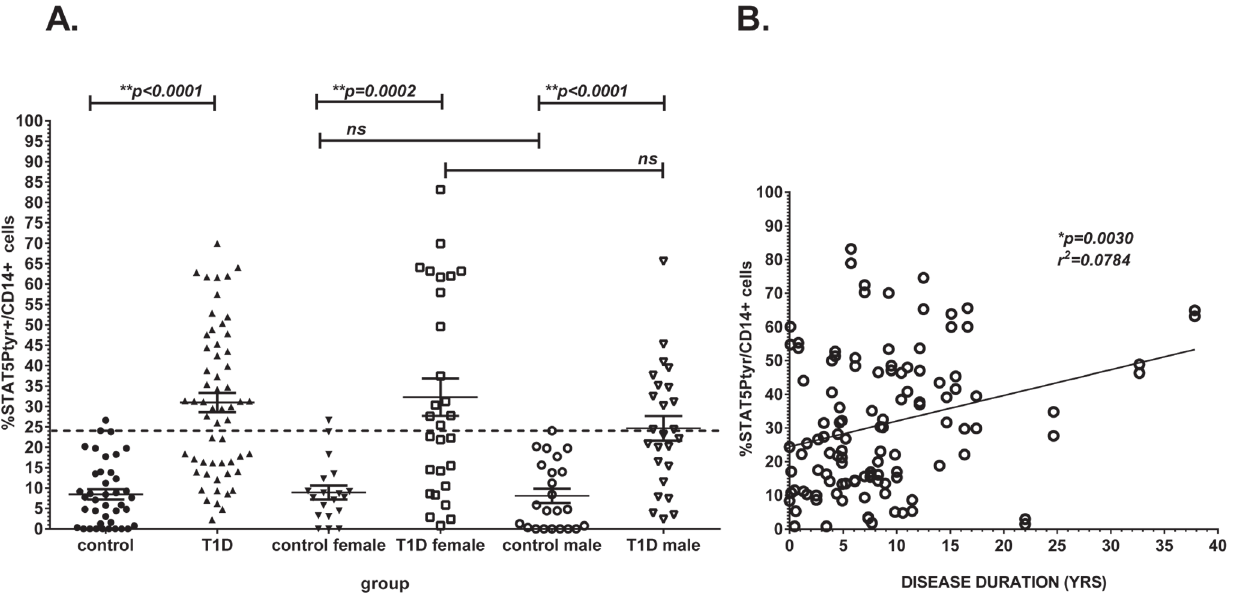
Figure 3. STAT5 Phosphorylation in CD14 + Peripheral Blood Monocytes and Correlation of STAT5Ptyr with Duration of Disease. A. Unactivated monocytes from 53 T1D patients had significantly higher activated STAT5 without ex vivo activation than monocytes from 37 healthy, non-autoimmune controls as analyzed by intercellular flow cytometry using small volume ( , 100 m l) whole peripheral blood samples (control mean 8.46% 6 7.83 SD, T1D 30.97% 6 18.00 SD, p , 0.0001, Mann Whitney U test). Gender did not affect these data, though a trend for higher values in female T1D monocytes was seen: control females mean 8.904% 6 7.445 SD, n=17 vs. control males mean 8.904% 6 8.242 SD, n=20, (p=0.6463, Student t test); female T1D subjects 32.30% 6 24.37 SD; n=28, vs.T1D male subjects 24.62% 6 15.07 SD; n=25, (p=0.4820, Mann-Whitney U test). Overall, 59.65% of T1D subjects had %STAT5Ptyr/CD14 levels at or above the control mean + 2 standard deviations (24.12%; indicated by the dashed line) compared to 2.44% of controls. B. No correlation with age was seen in any of the test groups; however, a trend for increasing %STAT5Ptyr levels with age was noted. This trend revealed a significant correlation of %STAT5Ptyr levels with disease duration within the T1D subject group (p=0.0005, linear regression, R 2 value=0.0784). Due to the very low sample volumes tested, most but not all samples were analyzable in duplicate from a single random blood draw. Data points on graph depict average of replicates for each individual.